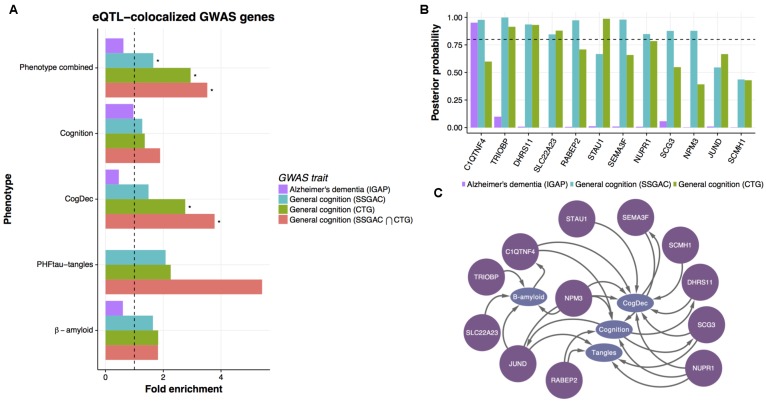
Enrichment of general cognition GWAS signals in upstream genes. (A) The enrichment of genetic associations in upstream genes based on eQTL co-localized genes. The enrichment of genes showing co-localized eQTL and AD or general cognition GWASs in upstream genes was evaluated by hypergeometric test. An asterisk indicates p-value < 0.05. (B) The posterior probability of co-localization for genes enriched in upstream genes. (C) Predicted relationships between genes colocalized with general cognition GWASs and phenotypes in LRNs.